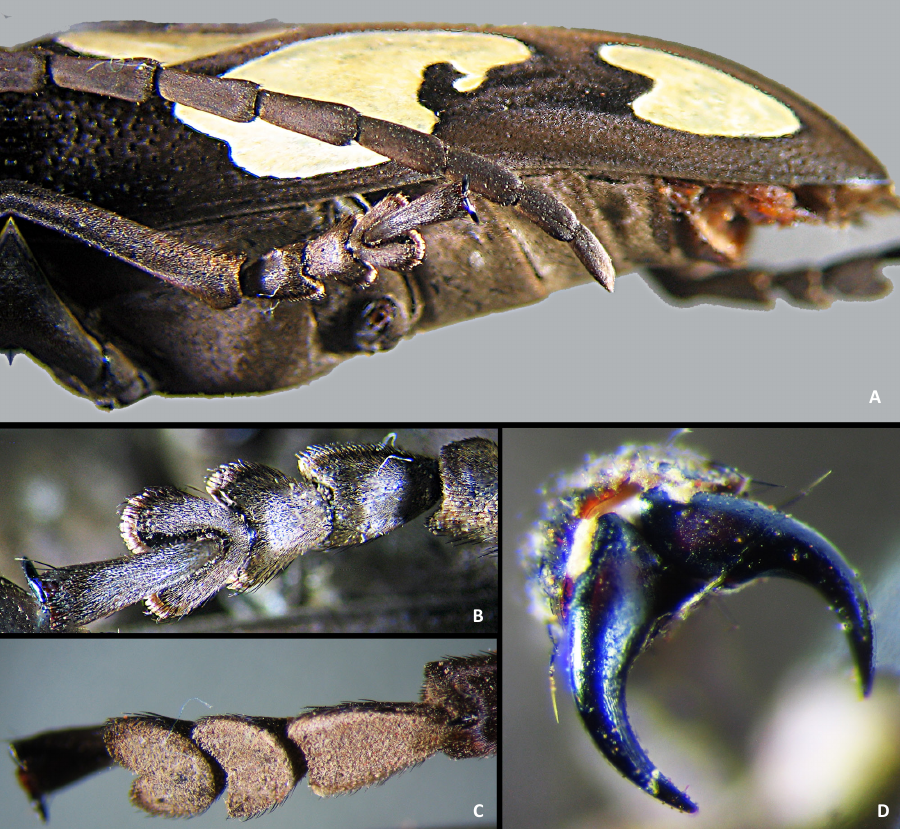
Image 2. Calothyrza margaritifera : A—Lateral view showing elytral maculae | B—Mid leg tarsus and claw in dorsal view | C—As in B ventral view | D—Claw. © Hemant V.